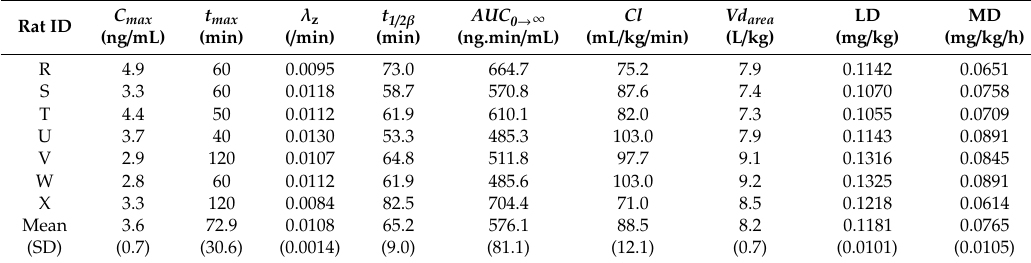
Table 2. Individual and mean ( ± standard deviation) pharmacokinetic (PK) and pharmacodynamic parameters after administration of 0.05 mg/kg SC medetomidine in seven Sprague-Dawley rats. C max = maximum serum concentration; t max = time of C max ; λ z = elimination rate constant; t 1/2 β = elimination half-life; AUC 0 → ∞ = area under the serum concentration time curve from time = 0 to ∞ ; Cl = total body clearance; Vd area = volume of distribution at pseudo-equilibrium; LD = loading dose; MD = maintenance dose.